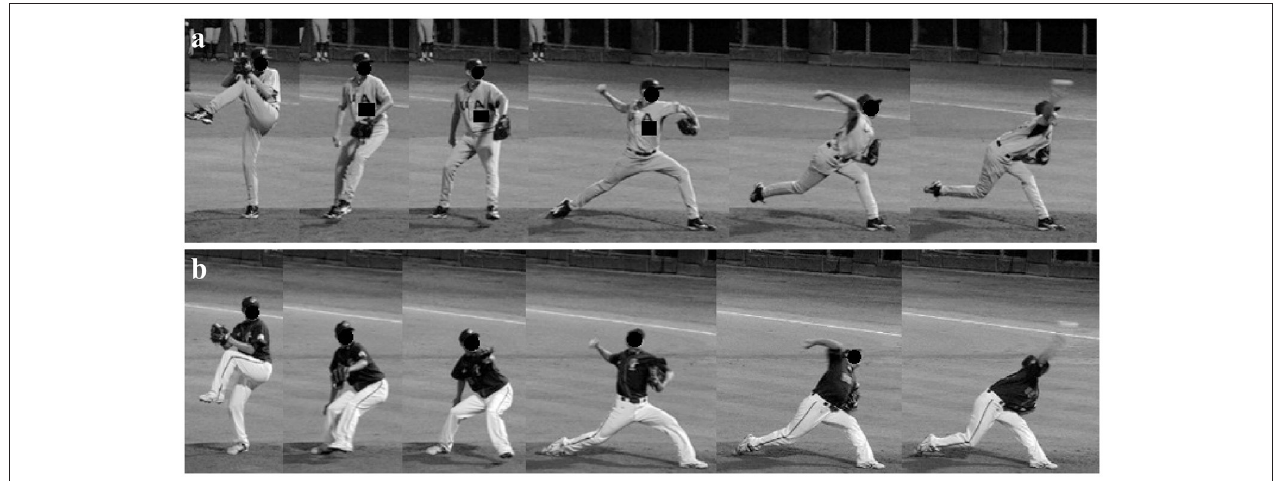
FIGURE 1 | Time-lapse photographs of the pitching motion of a typical tall-and-fall-type pitcher (a) and a typical dip-and-drive-type pitcher (b)